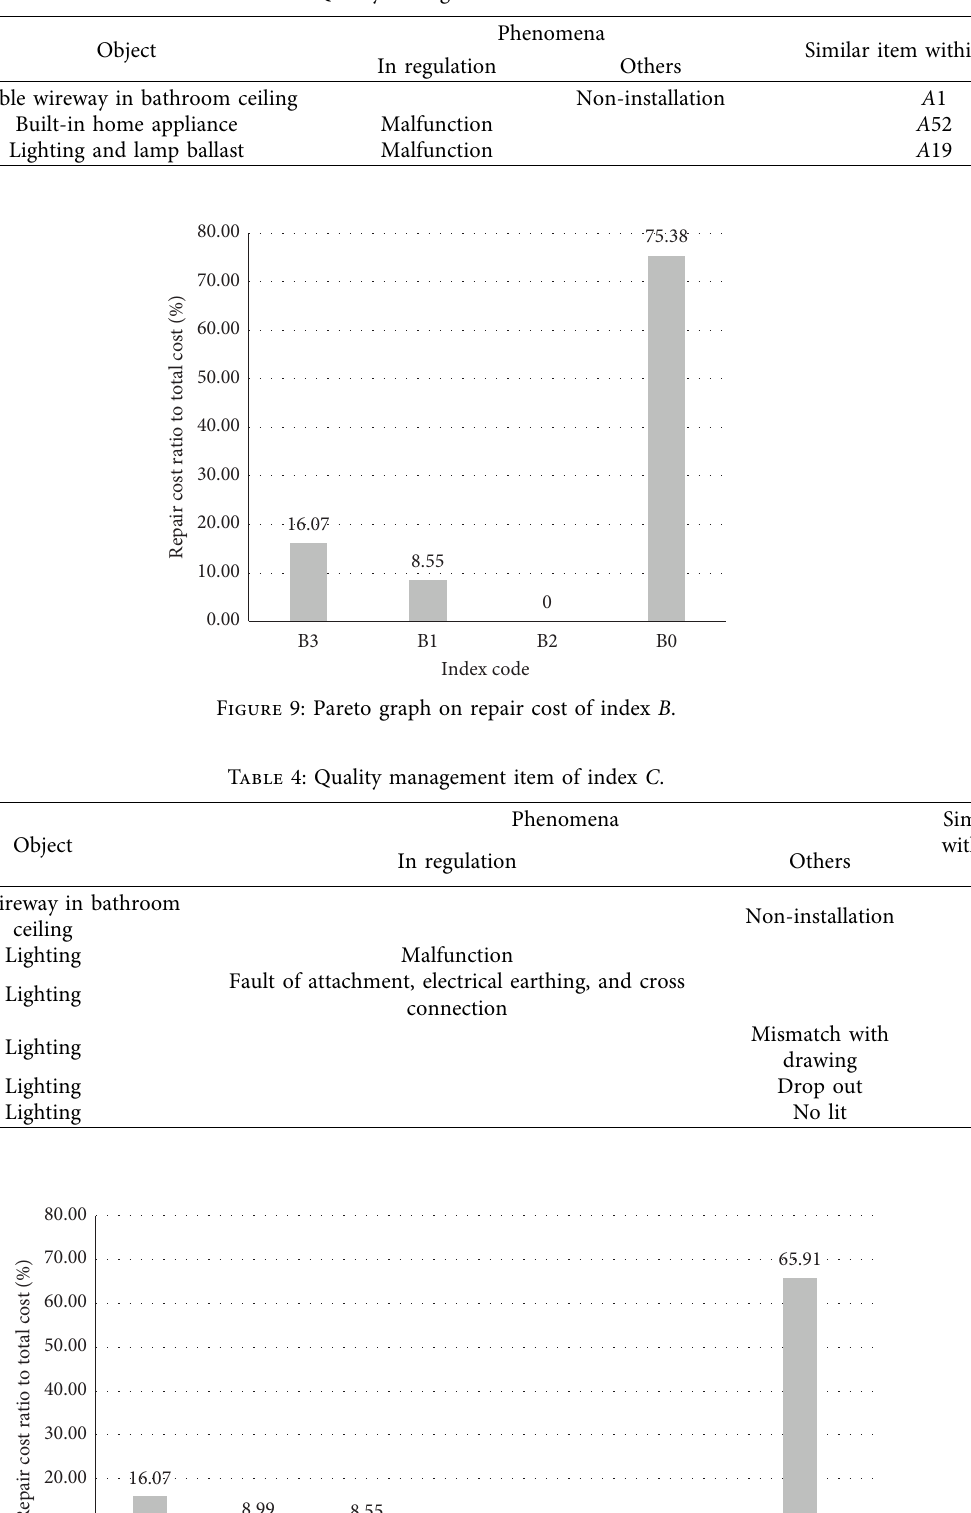
Table 3: Quality management item of index B .